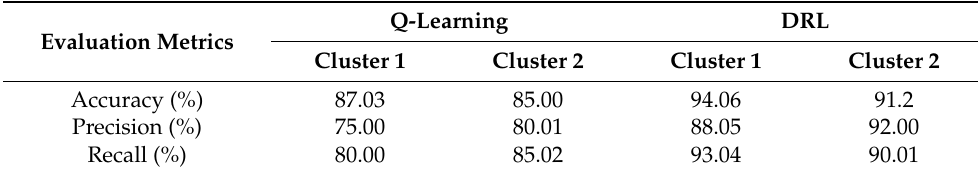
Table 5. Performance